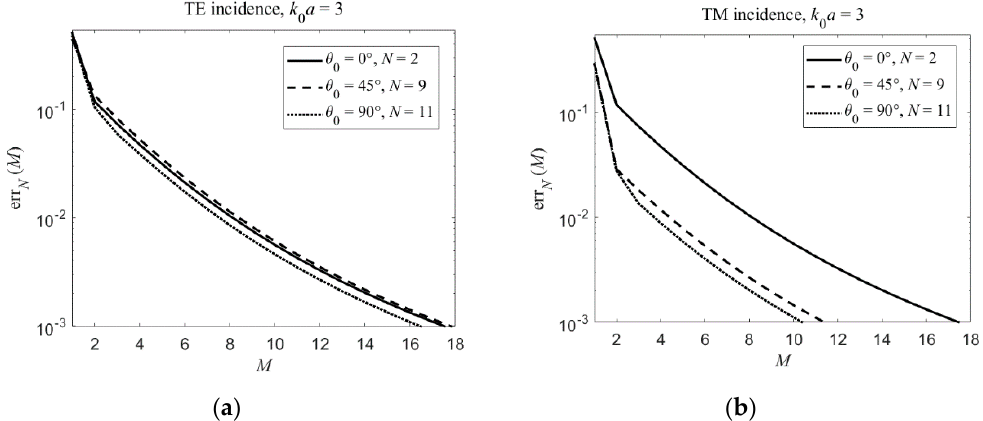
0 ,45 ,90 θ = ° ° ° and 0 (cid:12) (cid:12) (cid:12) (cid:12) µ = µ (cid:12) E 0 (cid:12) = 1 V/m, ( a ) TE incidence 10.5 0.3 j ε ε= − , 0 μ μ= . 1V/m E = , ( a ) TE incidence 0 , 0 . 0 0